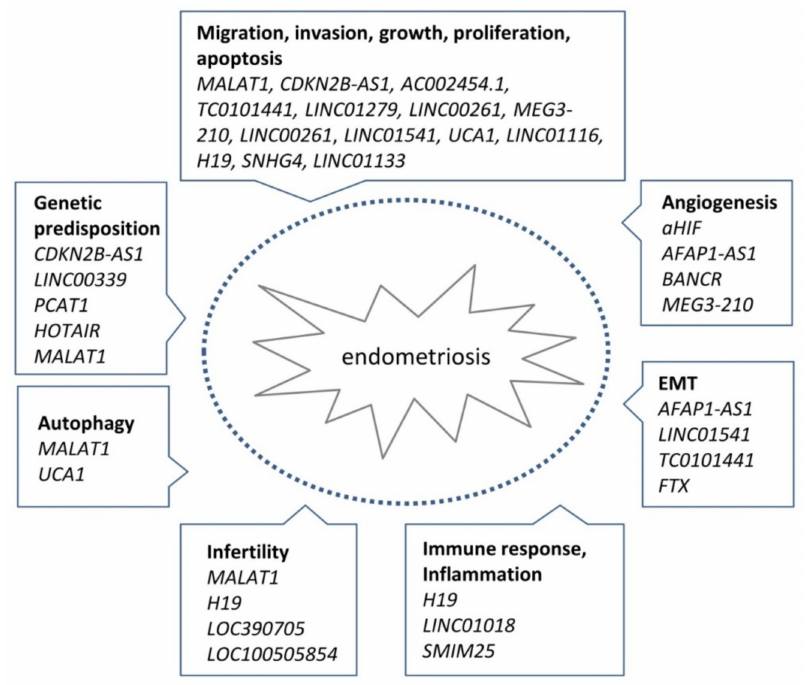
Figure 4. Phenotypical changes caused by altered expression of lncRNAs in endometriosis. Altered expression of lncRNAs in endometriosis is involved in the regulation of numerous processes known to be associated with the pathogenesis of the disease. These processes include EMT, endometriosis cell stemness, angiogenesis, lesion establishment and growth, endometriosis cell survival, proliferation and invasion, oxidative stress, autophagy, and endometrial